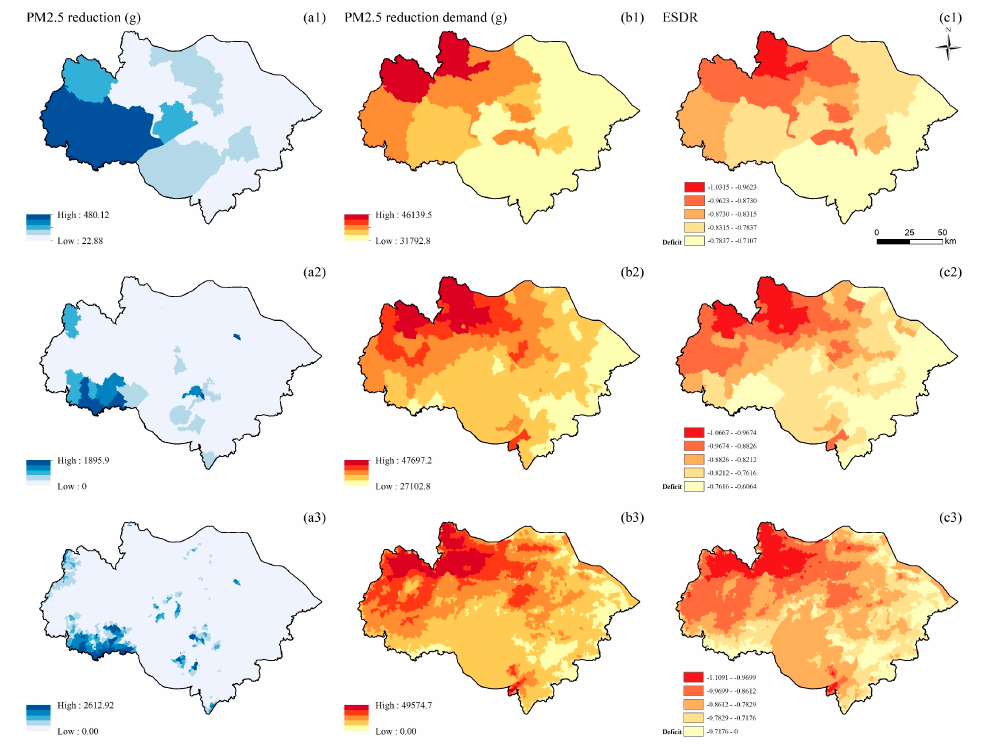
Figure 4. Spatial distribution of PR (unit: g/900 m 2 ) at the county ( a1 , b1 , c1 ), township ( a2 , b2 , c2 ), and village ( a3 , b3 , c3 ) scales; supply of PR ( a1 – a3 ); demand of PR ( b1 – b3 ); ESDR ( c1 – c3 ).